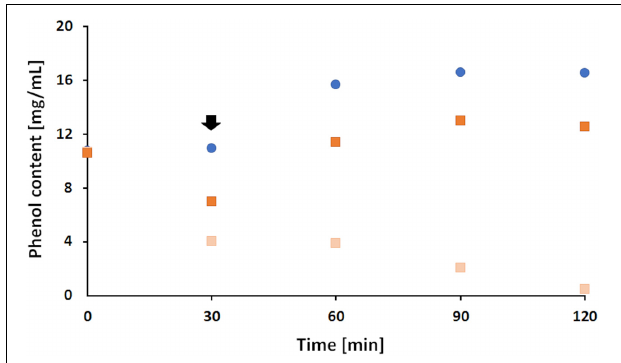
FIGURE 4 | Changes in phenolic content during laccase catalyzed coupling of FP onto LS. Addition of 2% (w/v) FP after 30 min (indicated by the black arrow) to an ongoing polymerization of LS at 33 ◦ C and a pH of 7 (dark orange squares). The reaction was compared to a blank sample (blue dots) of LS and FP but without enzyme and to a control sample that contained LS and enzyme only (light orange